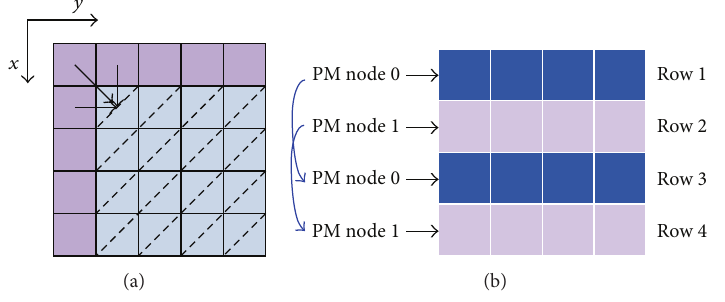
Figure 9: (a) Wavefront Computation; (b) its parallelization.